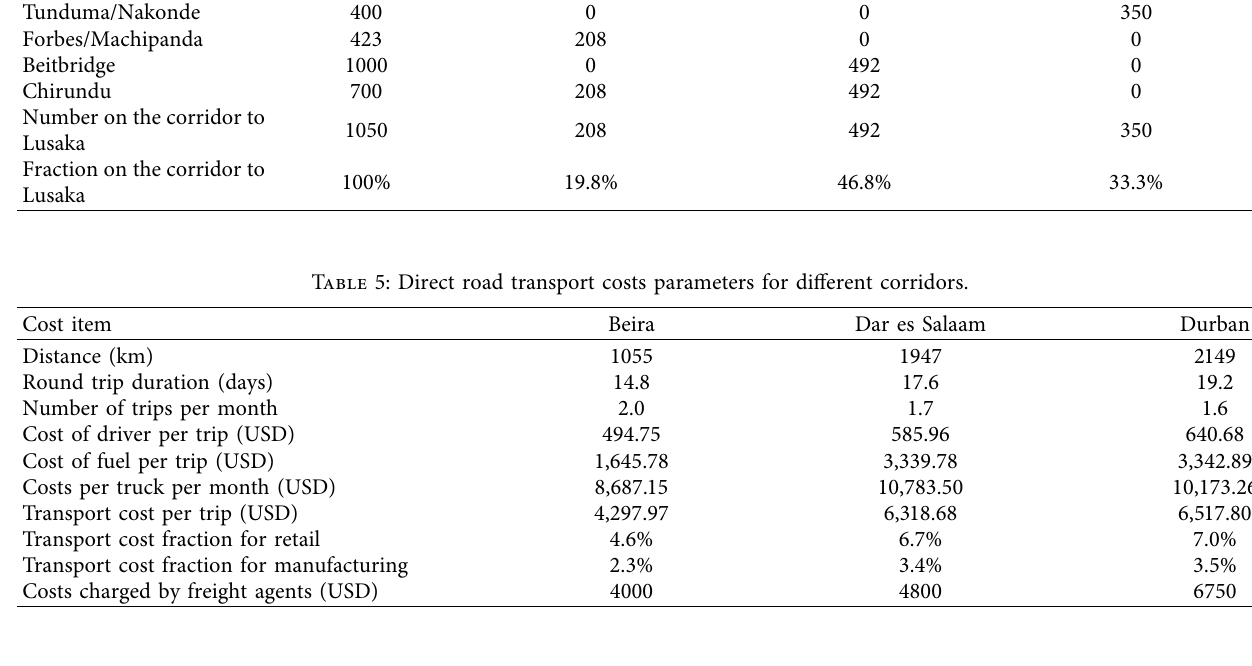
Table 6: Statistics of total corridor delay